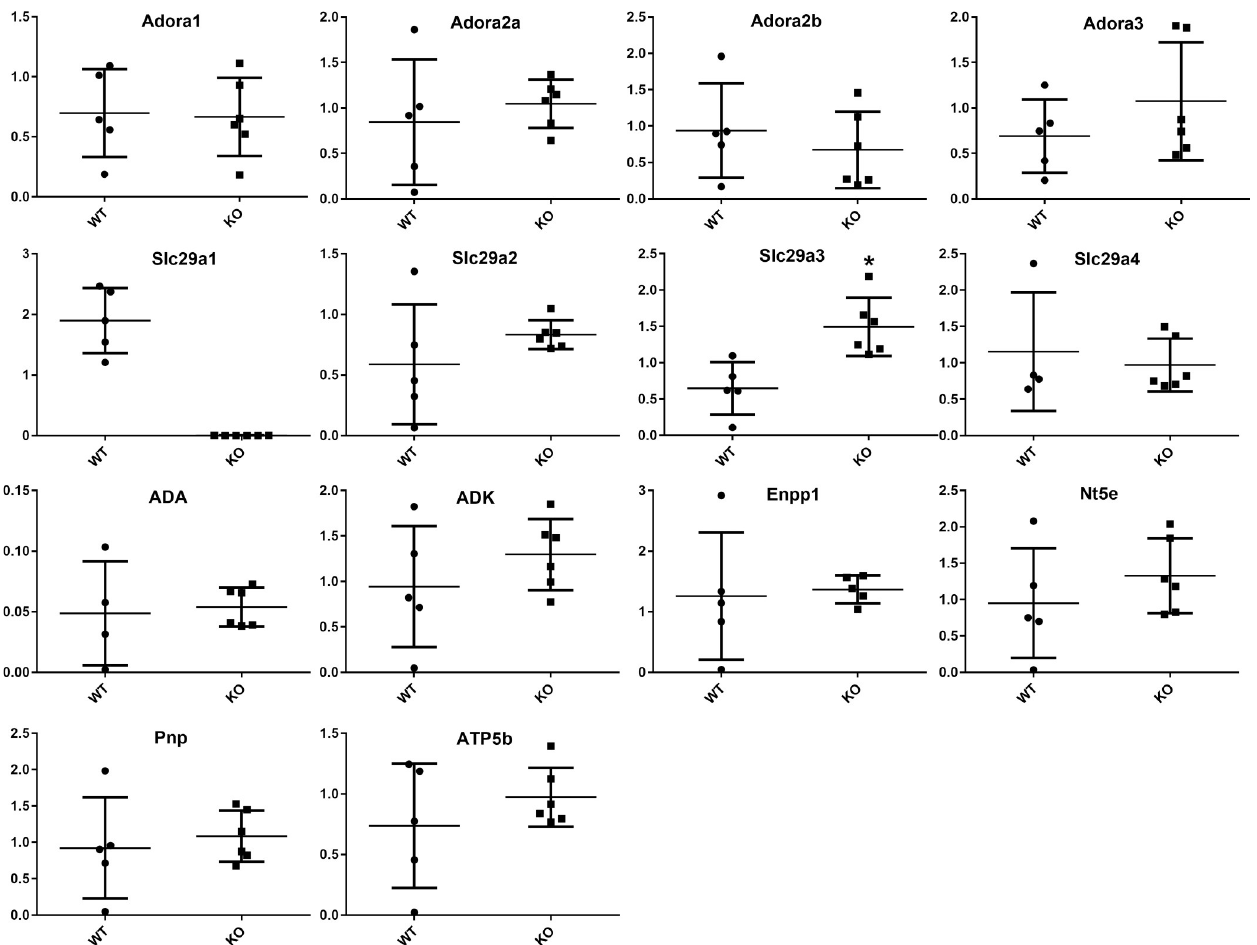
Fig 4. Gene expression in wildtype and Slc29a1-null mice: qPCR was employed, using the primer sets shown in S1 Table, to assess the relative expression of the equilibrative nucleoside transporters, Slc29a1 , Slc29a2 , Slc29a3 , and Slc29a4 , the adenosine receptors, Adora1 , Adora2a , Adora2b , and Adora3 , and enzymes involved in purine metabolism, ADA , Nt5e , ADK , Pnp , Enpp1 , and ATP5b . Gene expression (mean ± SEM) is shown as relative to the geometric mean of the reference genes UBC , eIF4a2 , and ActB . � Significant difference between wild-type (N = 5) and Slc29a1 -null (N = 8) mice (Student’s t-test for unpaired samples, two-tailed, P <